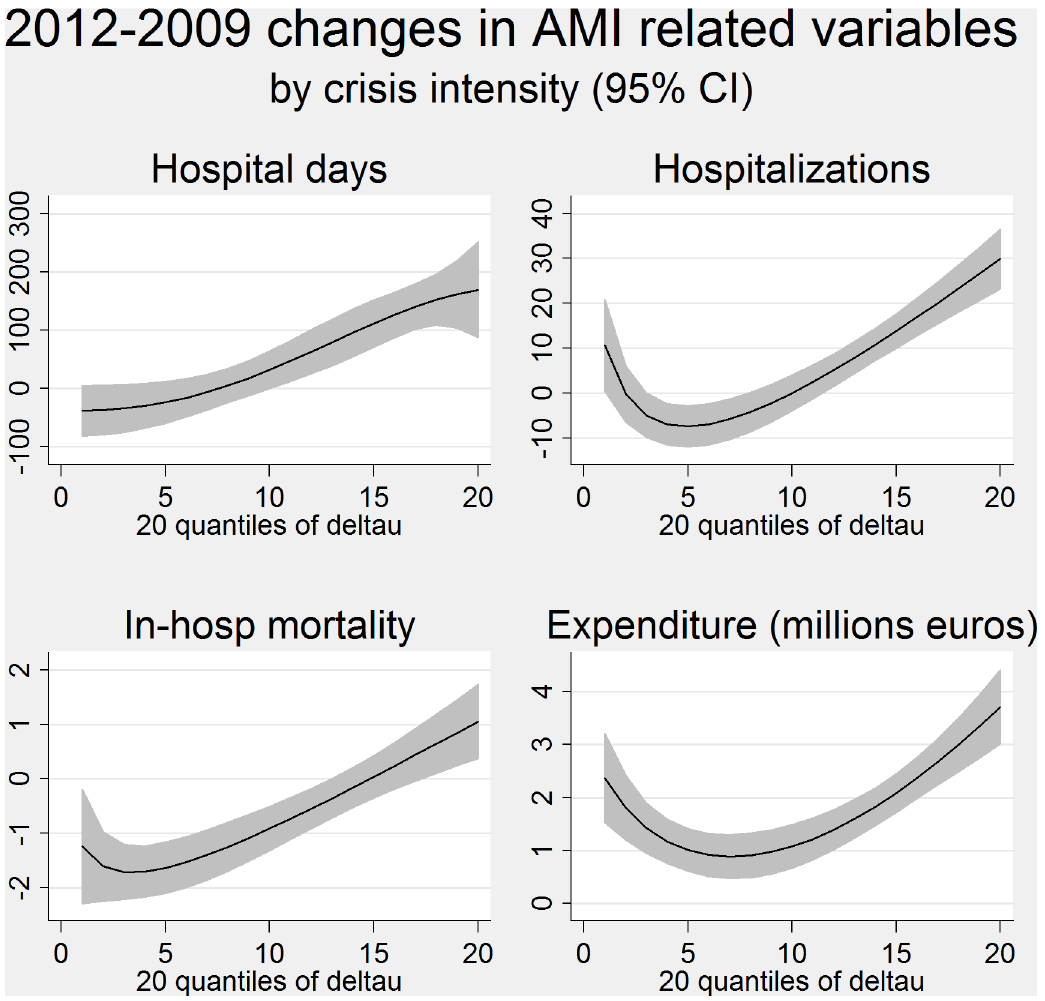
Fig 1. The fractional polynomial fit of changes in the outcome quintiles (20) of crisis intensity, with 95% confidence